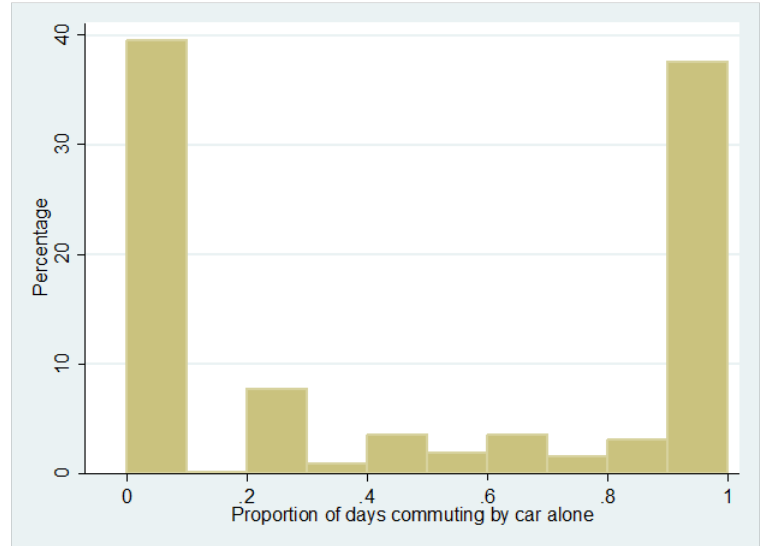
Figure 1. Distribution of days commuting by car alone at wave